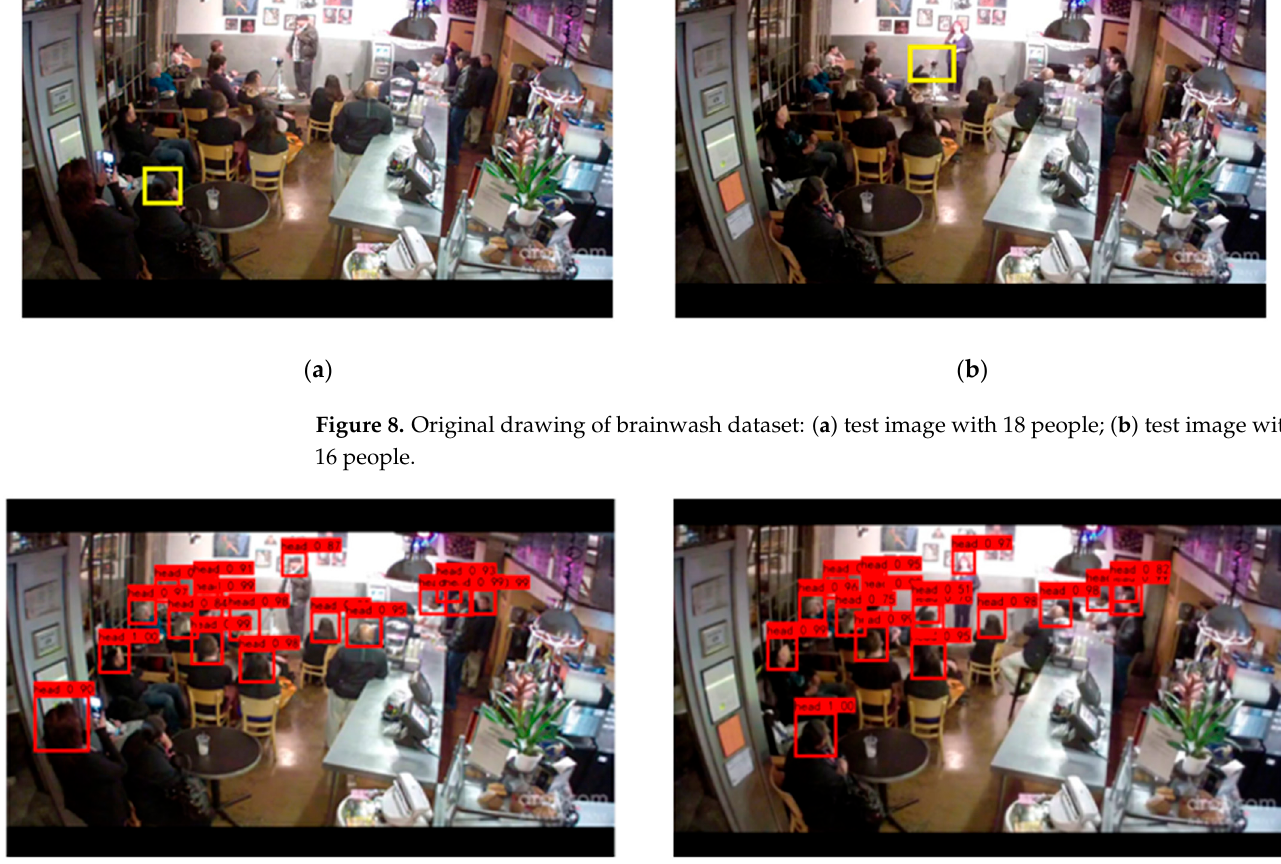
Figure 8. Original drawing of brainwash dataset: ( a ) test image with 18 people; ( b ) test image with 16 people.